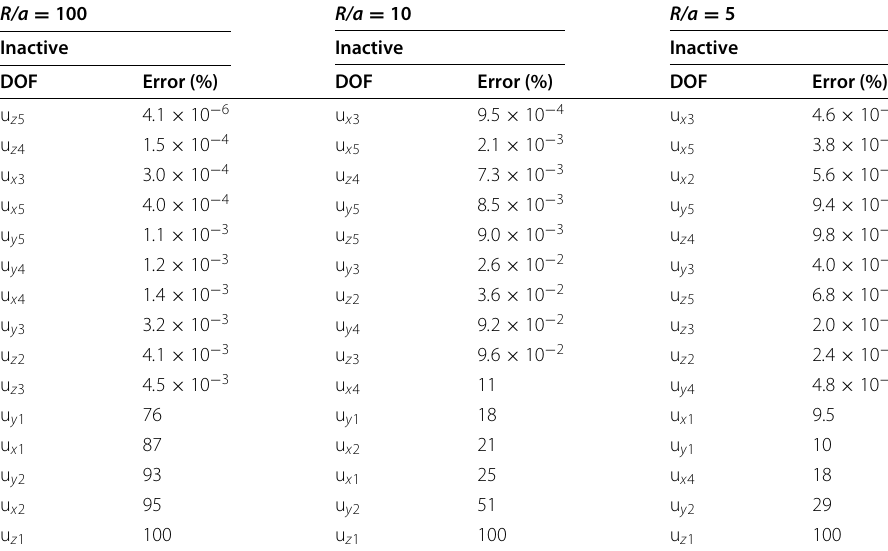
Table5 Errors for all 14 DOF models, 0/90/0, R/a = 5 , a/h = 5 R/a = 100 R/a = 10 R/a = 5 Inactive Inactive Inactive DOF Error (%)